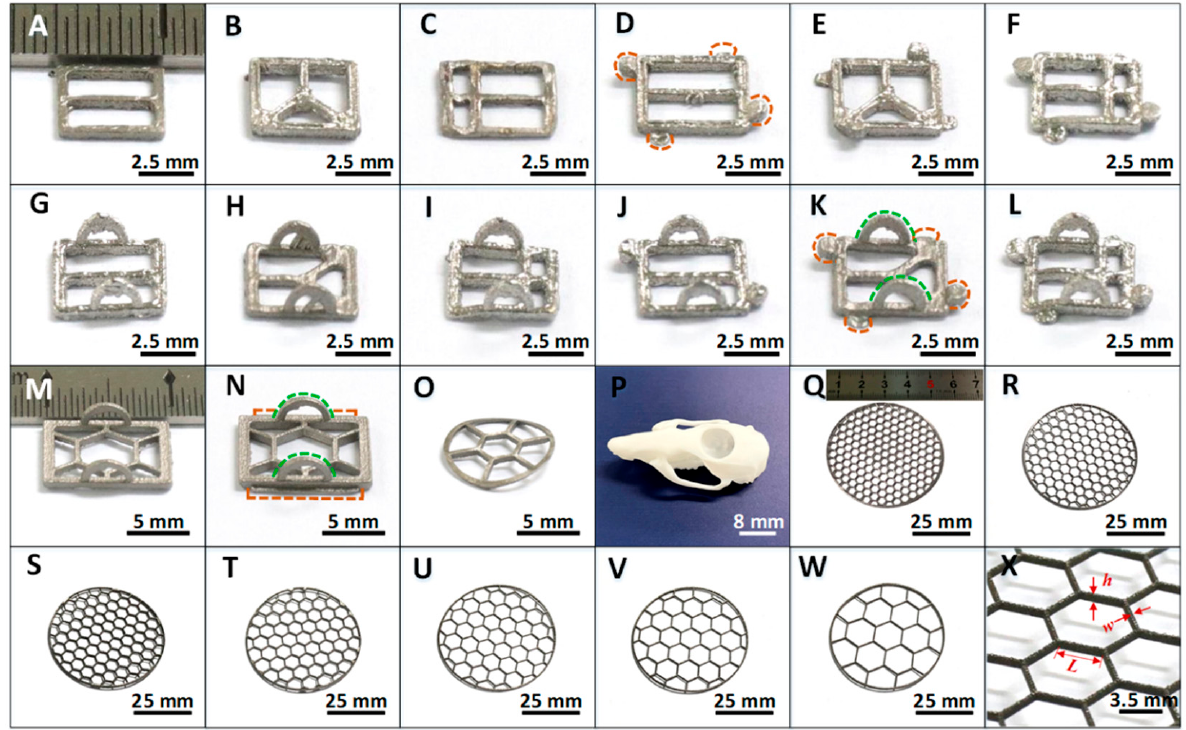
Figure 2. Optical images of the 3D printed Ti cranial frames with different shapes and sizes. ( A – L ) Small rectangular frames for mouse experiments. The orange dotted lines in ( D ) and ( K ) marked the locking parts on Ti frames, and the green dotted lines in ( K ) marked the clamping parts. ( M , N ) Rectangular frames for rat experiments. The orange and green dotted lines in ( N ), respectively, marked the locking and clamping parts on Ti frames. ( O ) A circular, curved frame for rat skull. ( P ) Photograph of a resin rat skull mold. ( Q – W ) 50 mm diameter circular Ti frames with hexagonal grid shape of different mesh sizes. ( X ) A close look at the Ti frame shown in ( T ), with grid length L of 3.5 mm, grid width w of 0.3 mm and the device thickness h of 1.0 mm.